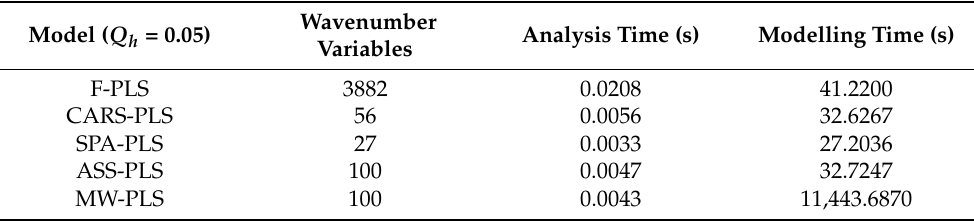
Table 3. Comparison of the number of wavenumber variables extracted, analysis time and the modelling time of several algorithm models in the six-component